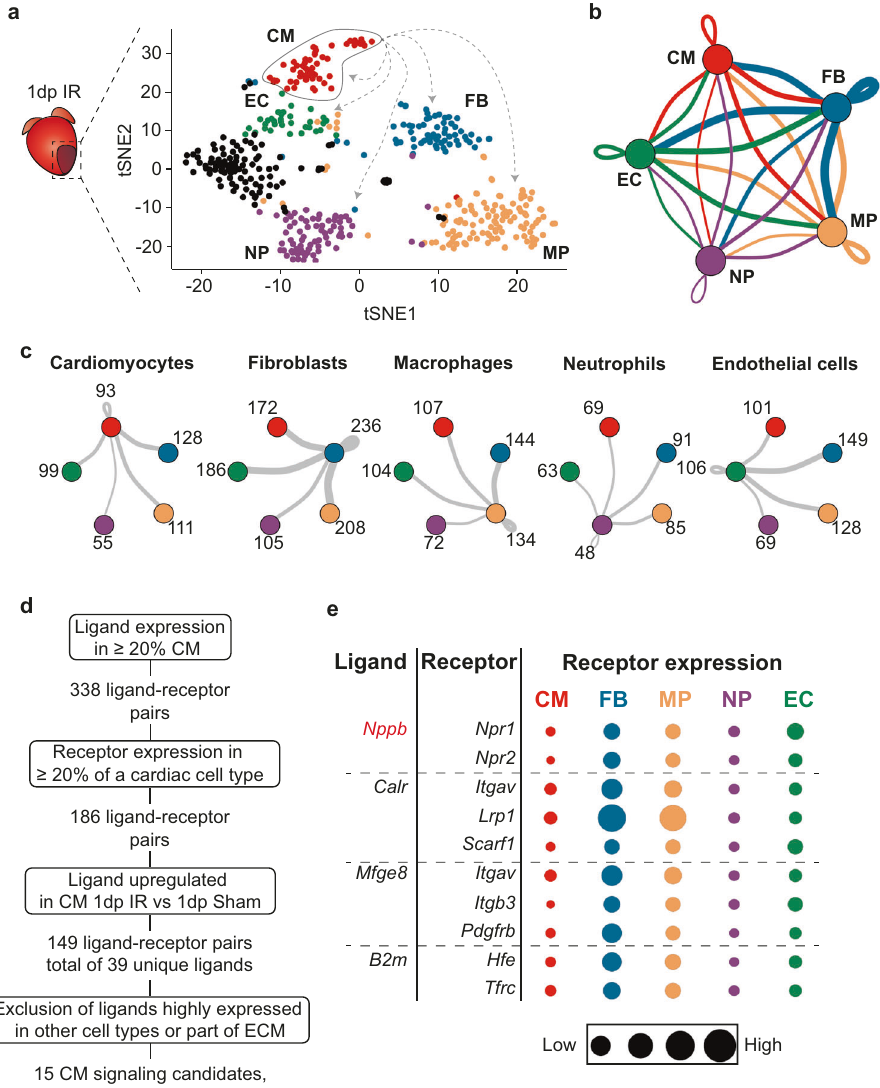
Fig. 5 Intercellular communication by autocrine and paracrine signaling in the ischemic heart. a tSNE plot of all cells obtained 1 dp IR. Colors indicate different cell types. CM cardiomyocytes, FB fi broblasts, MP macrophages, NP neutrophils, EC endothelial cells. To determine potential autocrine/paracrine signaling after ischemia, expression of ligands in one cell type was determined (e.g. cardiomyocytes highlighted by circle). Subsequently, the expression of cognate receptors was determined per cell type (highlighted by dashed arrows). b Spider graph illustrating the potential intercellular communications between cell types by ligand-receptor signaling. The line color depicts ligand expression in the cell type with the same color. Lines connect to cell types that express the corresponding receptor. Line thickness is proportional to the number of ligands expressed in one population for which the receptor is expressed in the other cell type, with loop indicating autocrine signaling. c Potential intercellular ligand-receptor signaling between cell types, described for each cell type separately. Numbers depict the number of ligand-receptor couples between inter-cell type links. d Schematic of the screening strategy used to identify potential ligands involved in autocrine/paracrine signaling between stressed cardiomyocytes and other cell types 1 dp IR. e Bubble plot showing ligands selected for downstream functional study with their cognate receptor(s). A positive control ( Nppb ) is depicted in red. The size of the bubble represents the expression of each receptor across all identi fi ed cardiac cell types 1 dp